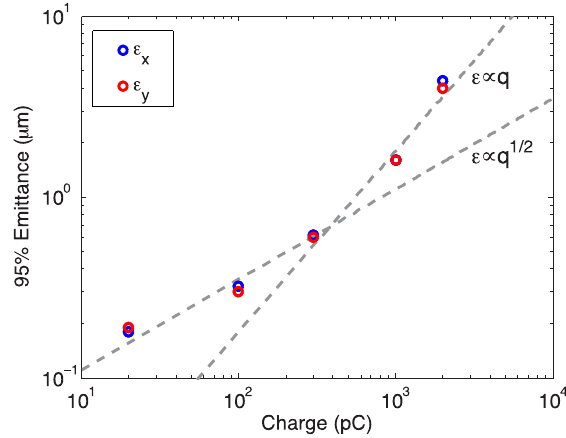
FIG. 8. Trend of the emittance as function of bunch charge.